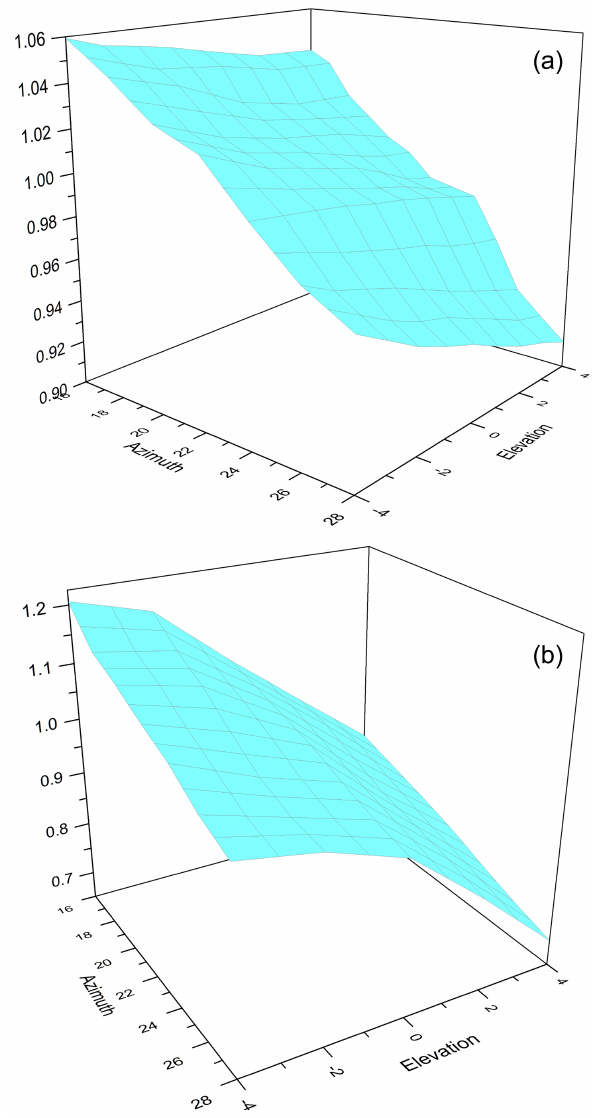
Figure 13. Goniometry correction factors for the aluminum dif- fuser (a) and QVD (b) for the CFOV.